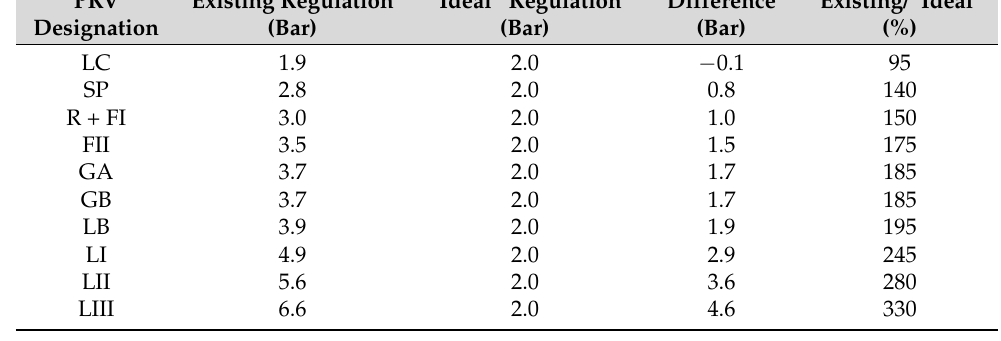
Figure 7. Ideal PRV and the difference between existing and ideal pressure regulation.